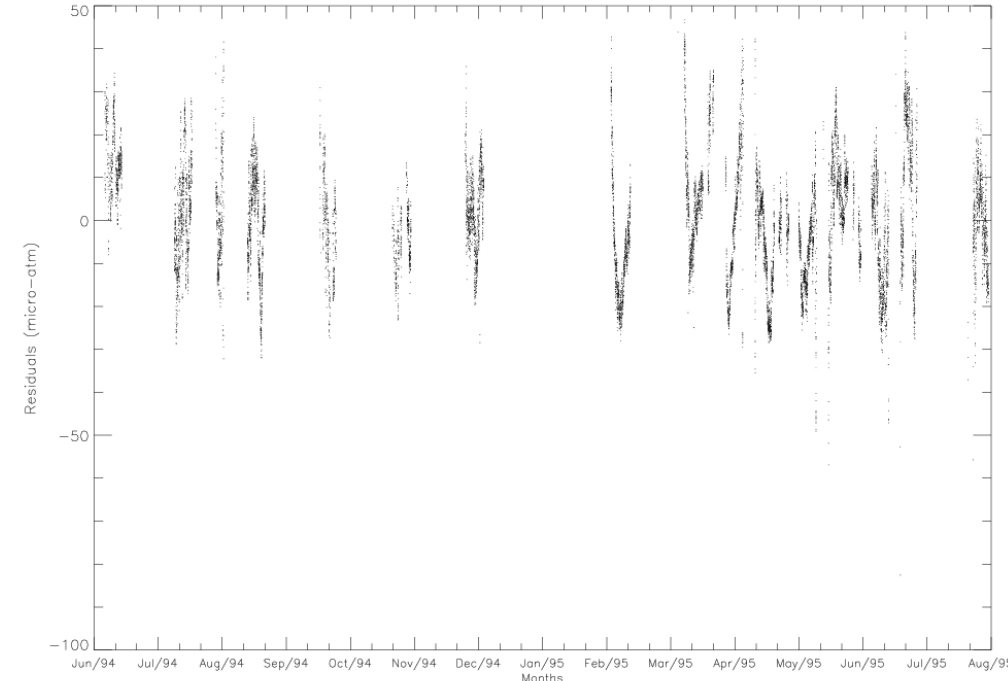
Fig. 3. Residuals values obtained with the following parametrization: pCO 2 = f (SST,CHL,MLD) as a function of the day of the year.